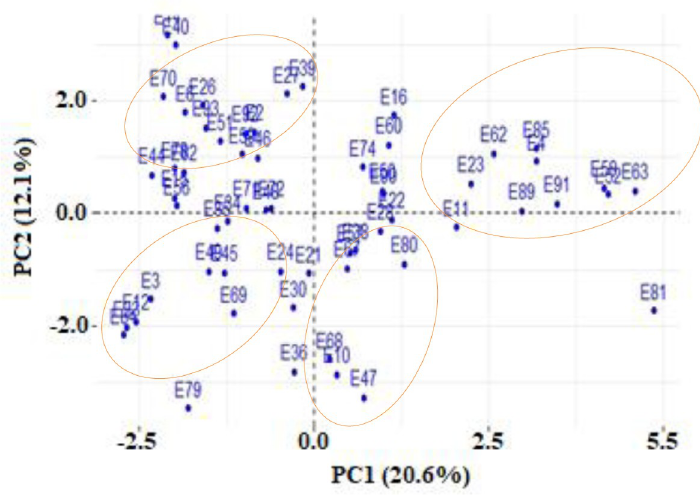
Fig 3. Principal commonent biplot of 60 common bean genotypes evaluated in two years.